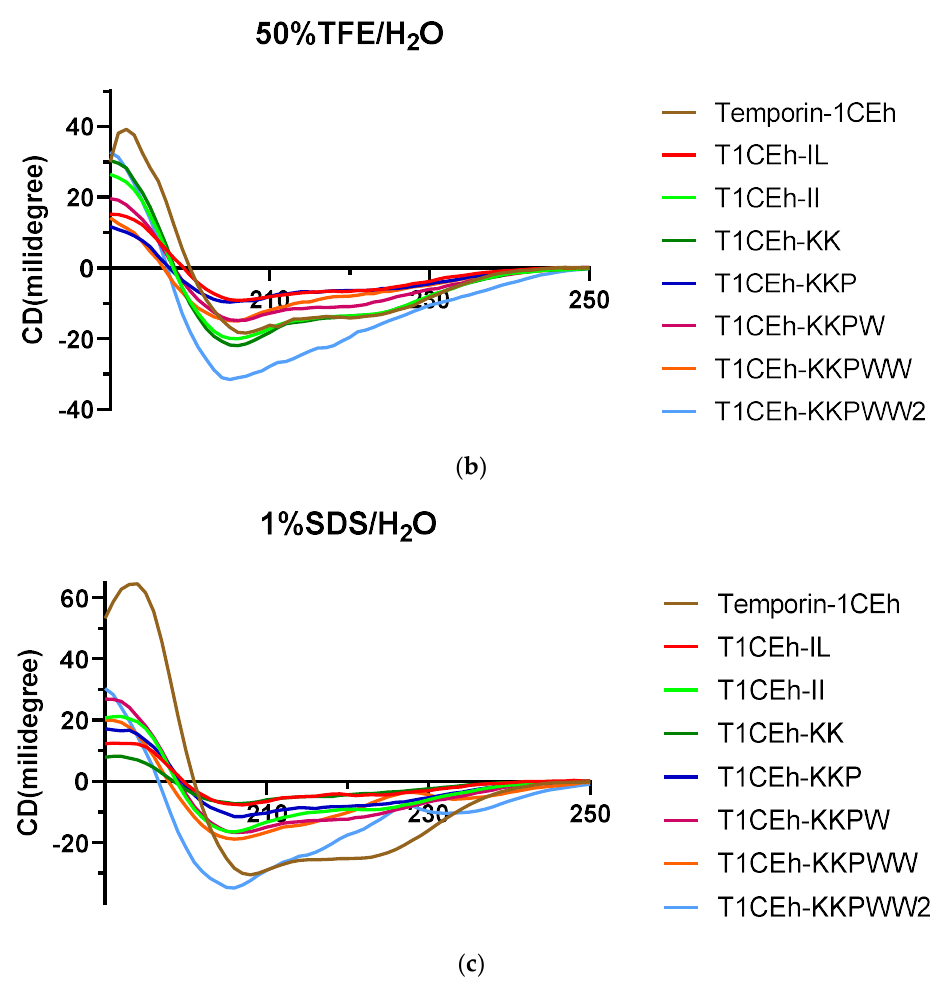
Figure 5. Circular dichroism (CD) spectra of 50 µM of Temporin-1CEh and its analogues in H 2 O ( a ), 50% TFE solution ( b ) and 1% SDS solution ( c ).